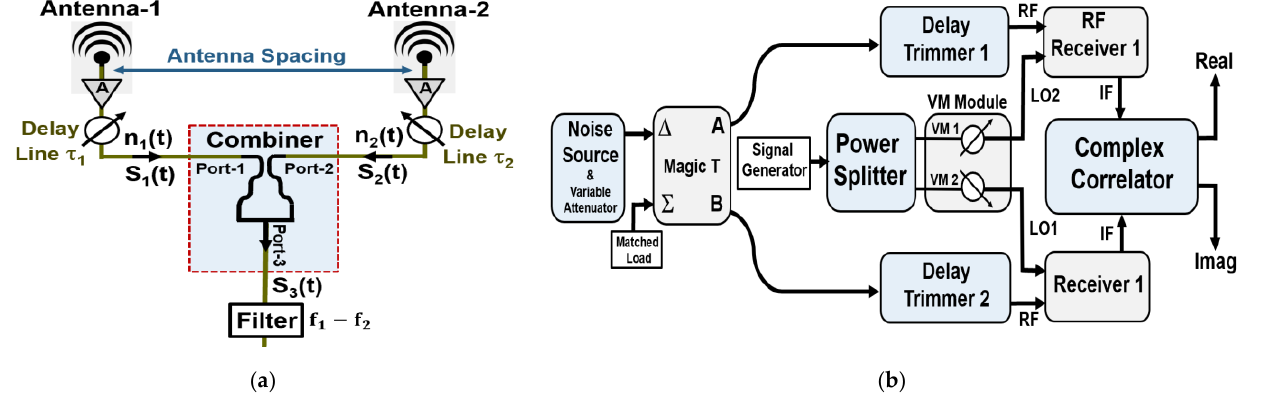
Figure 12. Dual-channel with delay lines and power-splitting for noise decorrelation ( a ). Test-bench solution including broadband delay lines and power-splitters for noise decorrelation using IQ signals ( b ).